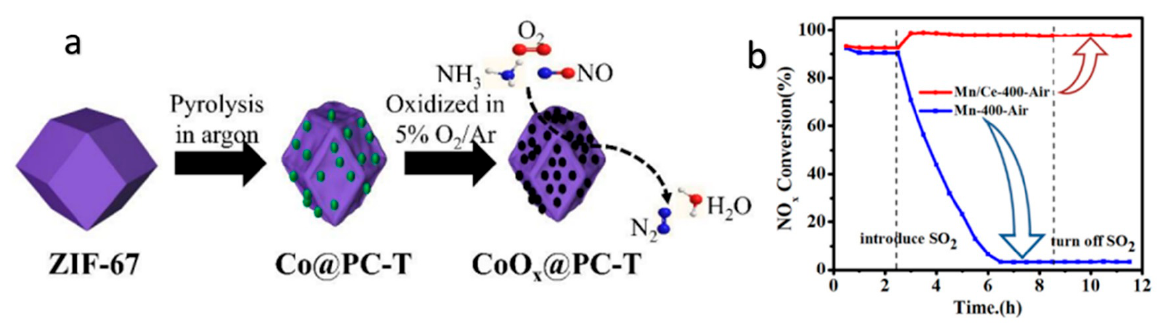
Figure 4. MOF-derived catalysts for NO x SCR, ( a ) CoOx@PC-T [28] (copyright 2019 Elsevier), ( b ) Ce- Mn oxide [33] (copyright 2021 Elsevier).